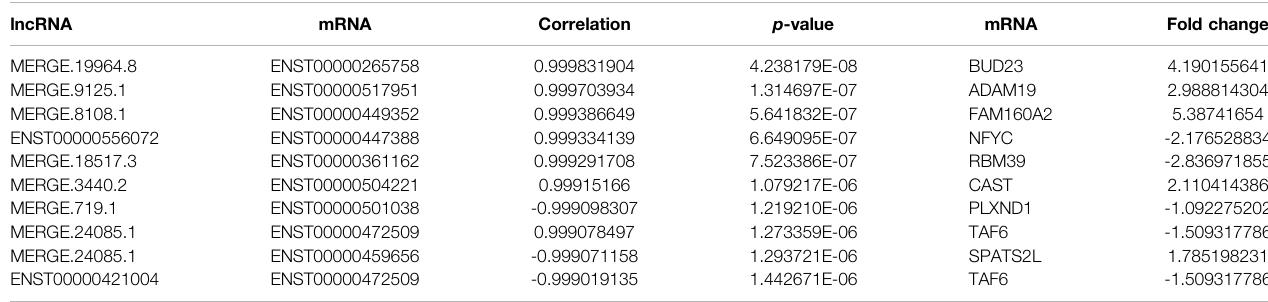
TABLE 3 | The top 10 coexpressed lncRNAs and mRNAs in moDCs. lncRNA mRNA Correlation p -value mRNA Fold change